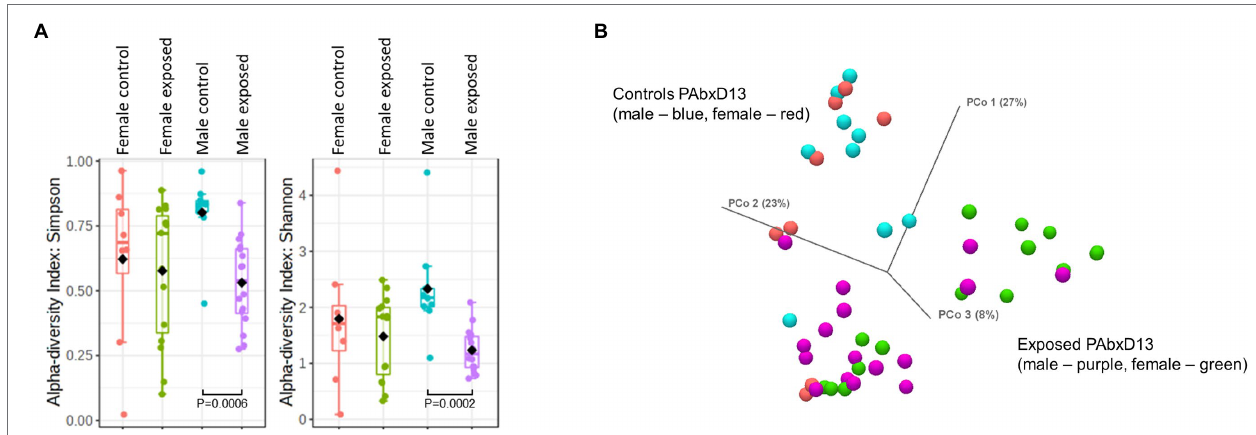
FIGURE 5 | Microbial alpha and beta diversity in small bowel samples from male and female control and exposed rats. (A) Small bowel alpha diversity in male and female control and exposed rats on PAbxD13, as measured by Simpson’s and Shannon’s indices. Exposed males vs. control males: Simpson’s index p = 0.0006, Shannon’s index p = 0.0002. All other comparisons p = NS. (B) Small bowel beta diversity in male and female rats on PAbxD13 (control males—red, control females—blue, exposed males—purple, and exposed females—green). Male vs. female controls: PERMANOVA p = 1. Exposed females vs. exposed males